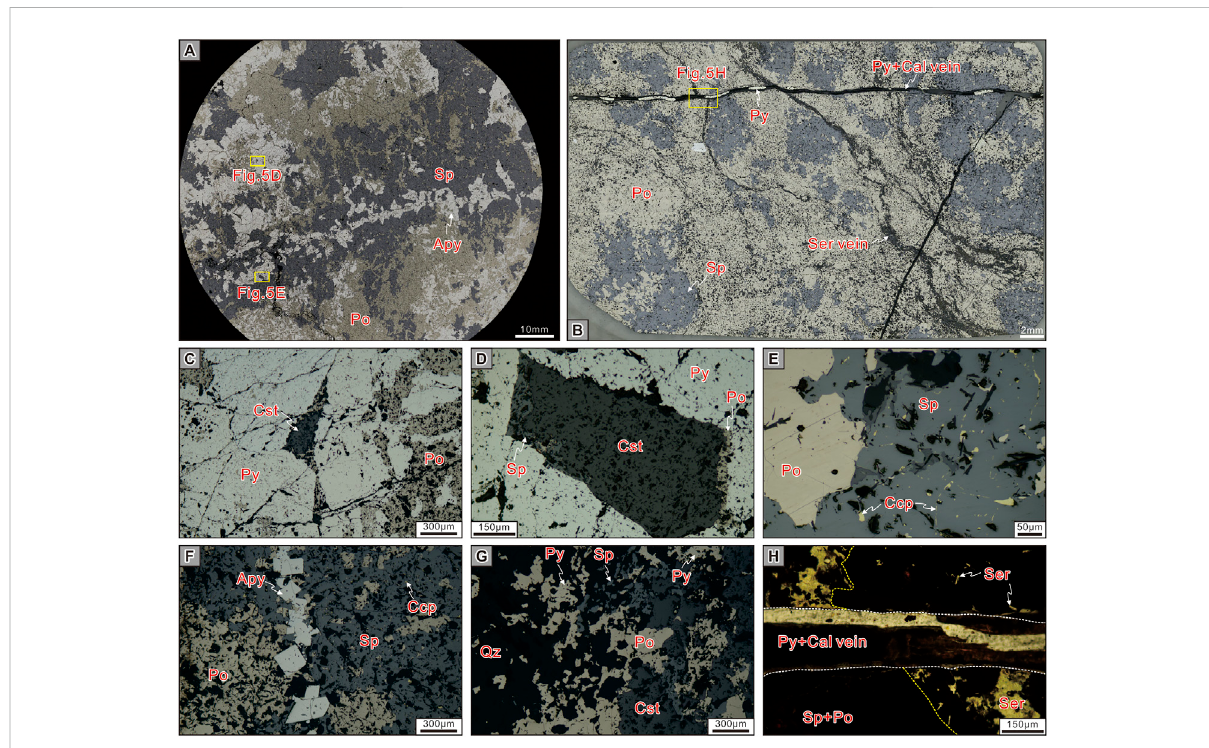
FIGURE 5 Representative textures and mineral assemblages within ores and wall rocks of Baimianshan Zn-Sn segment. (A) The re fl ected mapping of polished slab of XLM1902. (B) The re fl ected mapping of thin section XLM1901T showing the pyrite vein replaced the massive pyrrhotite-sphalerite. (C – D) Cassiterite coexisted with arsenian pyrite and replaced by the pyrrhotite, sphalerite. (E) The pyrrhotite laths and lamellae, chalcopyrite blebs intergrewwithsphaleriteandpyrrhotite. (F) Theeuhedralarsenopyritequartzveinletcrosscutthepyrrhotiteandsphalerite. (G) Thepyritequartz replaced the sphalerite and pyrrhotite. (H) The pyrite-calcite vein cut the massive pyrrhotite and sphalerite which were replaced sericite.